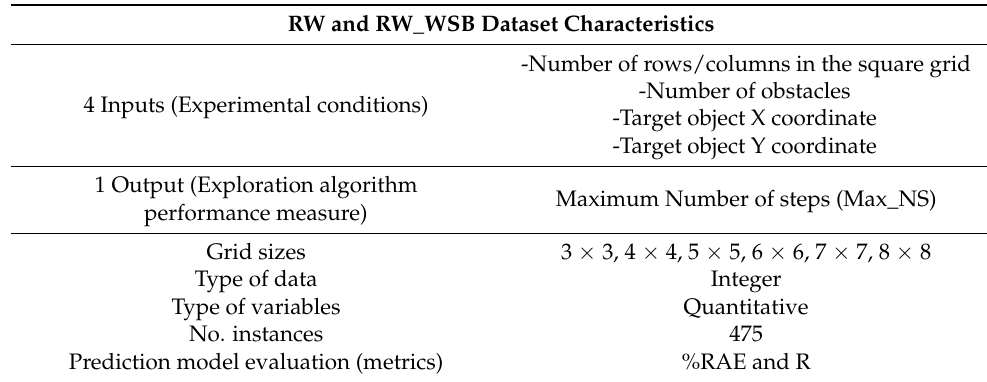
Table 1 . Characteristics of the datasets used for training, validation and testing.